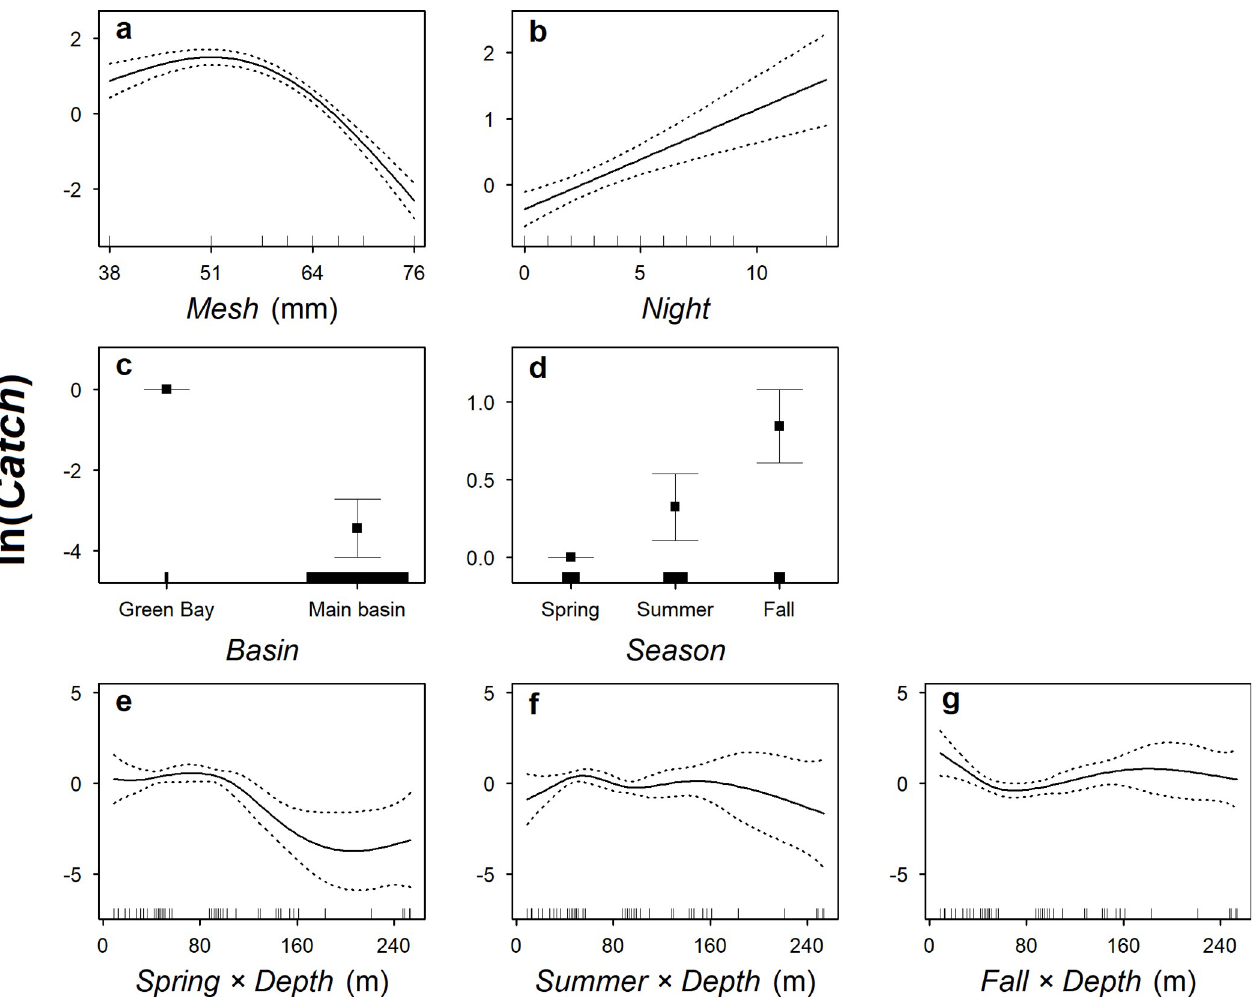
Fig 4. The relationships between predicted number of Cisco caught ( Catch ) and predictors in the selected generalized additive model fitted to gill-net data collected from Lake Michigan in 1952–1962. Mesh is a continuous variable representing gill-net mesh size (stretch). Night is a continuous variable number of nights fishing ( Night = 0 means that gill nets were set in the morning but lifted before midnight). Basin is a categorical variable representing the two sub-basins, Green Bay and the main basin, in Lake Michigan. Season is a categorical variable representing spring, summer, and fall. Depth is a continuous variable representing bottom depth of which a smoothing function was fitted for each season. In panels for the smoothing functions (a–b and e–g), solid lines represent the predicted values, dotted lines represent +/ − one standard error, and ticks above the horizontal axis represent the distribution of data points. In the panels for categorical variables (c and d), points represent the predicted values, error bars represent +/ − one standard error, and ticks above the horizontal axis represent relative sample size. The final predicted values of Catch still need to be adjusted for spatial variability (i.e., latitude and longitude), offset values (i.e., gill-net mesh area), and the intercept in the model. At the same scale of ln( Catch ), the model has an intercept of − 2.435, with a standard error of